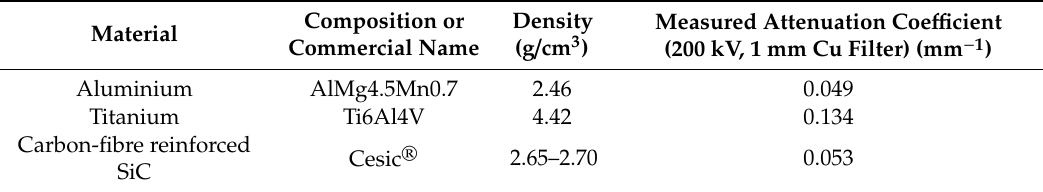
Table 1. Material properties used in the selected